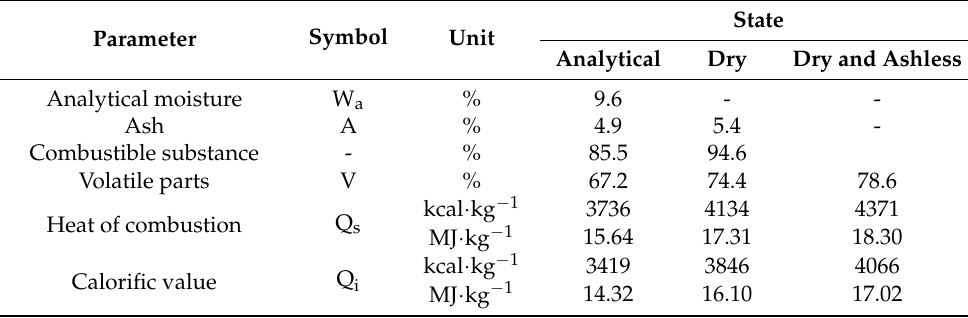
Table 10. Energy parameters of tuber sunflower straw, ‘Albik’ variety